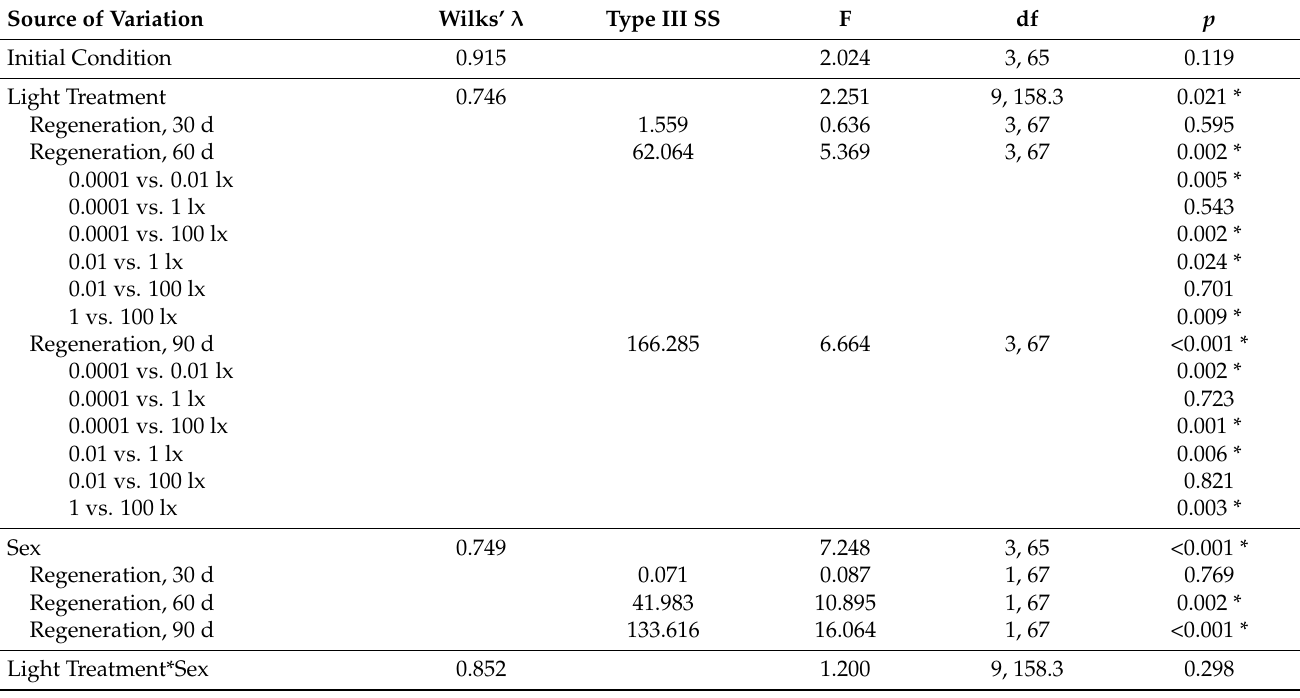
Table 1. MANCOVA analyzing the effect of nocturnal ambient light (light treatment, lx), sex, and the interaction of light and sex on regeneration lengths of tails (mm) at 30, 60, and 90 d after inducing tail autotomy in red-backed salamanders. Initial body condition (residuals of mass on snout-vent length, SVL) was used as a covariate in the analysis. Significant multivariate tests were further analyzed with ANCOVA. Significant ANCOVA tests for light treatment were further analyzed with LSD tests to determine pairwise